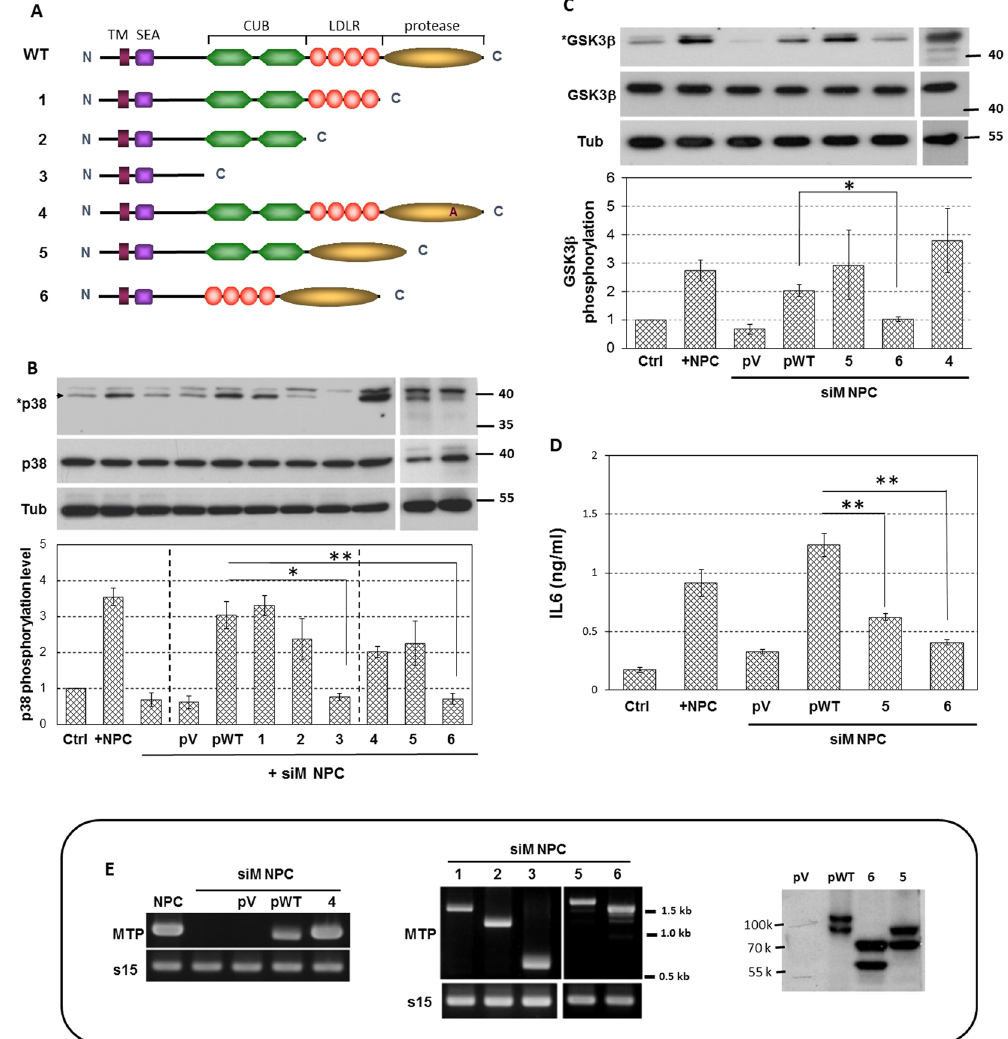
Figure 2. CUB motifs of MTP are the key elements for induction of endothelial signaling activation in NS/P cell and bEnd cell contact co-culture. ( A ) Schematic illustration of full-length MTP protein structure (WT) and the various deletion constructs (1–5). Variant 6 contains a point mutation in the protease domain which diminishes the protease activity. ( B ) Western blot of phosphorylated or total p38MAPK ( * p38 and p38 respectively) in bEnd cells cultured alone (Ctrl), in contact co-cultured with wild type NS/P cells ( + NPC), in contact co-cultured with MTP-knockdown NS/P cells ( + siM NPC), or in contact co-cultured with MTP- knockdown NS/P cells carrying control empty expression vector (pV), the full-length wild-type MTP (pWT), or the various MTP constructs (1, 2, 3, 4, 5, or 6). Tub is the α -tubulin used as loading control for Western. Bar graph shows the quantitative data of the Western blot. Variants 5 and 6 were run on different gel from the others. The original blot of these samples was shown in Supplementary Fig. 1A. ( C ) Western blot of total and phosphorylated GSK3 β (GSK3 β and * GSK3 β , respectively) in bEnd cells cultured alone (Ctrl), in contact co- cultured with wild type NS/P cells ( + NPC), in contact co-cultured with MTP-knockdown NS/P cells ( + siM NPC), or in contact co-cultured with MTP-knockdown NS/P cells carrying control empty expression vector (pV), the full-length wild-type MTP (pWT), or the various MTP constructs (4, 5, or 6). Variant 4 was run on different gel from the others. The original blot of this sample was shown in Supplementary Fig. 1B. ( D ) ELISA assay of IL6 in the medium of bEnd cells cultured alone (Ctrl), in contact co-cultured with wild type NS/P cells ( + NPC), in contact co-cultured with MTP-knockdown NS/P cells ( + siM NPC), or in contact co-cultured with MTP-knockdown NS/P cells carrying control empty expression vector (pV), the full-length wild-type MTP (pWT), or the various MTP constructs (5 or 6). ( E ) Expression of the various MTP constructs in NS/P cells used in the co-culture. Left and middle panels are RT-PCR. Images were grouped together according to the expected product size. The deletion variants have different size were thus grouped to form the middle image. Expression of the full-length MTP, variants 5 and 6 was also shown by Western in the right panel. The bar graph in B and C show densitometry data of Western blots collected from 3–5 independent experiments and analyzed as described in Fig. 1. * P value ≦ 0.1; ** P value ≦